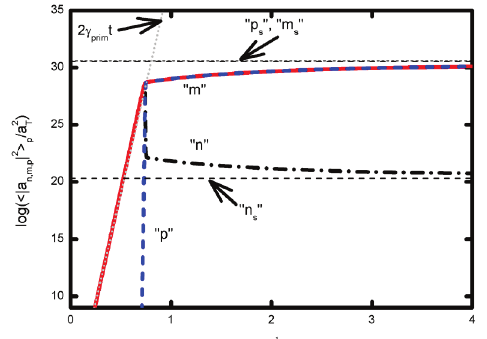
Fig. 1. Temporal evolution of the average number of daughter plasmons given in the logarithmic scale; “n” – > (dashed dotted line), “m” – > (solid line), “p” - > (dashed line); “n s ” – equation (14) (lower thin dashed horizontal line), “m s ” and “p s ” - equation (15) and equation (16) (merged upper thin dashed horizontal lines). The gain coefficient 2 t γ (short dotted line) of the primary decay waves